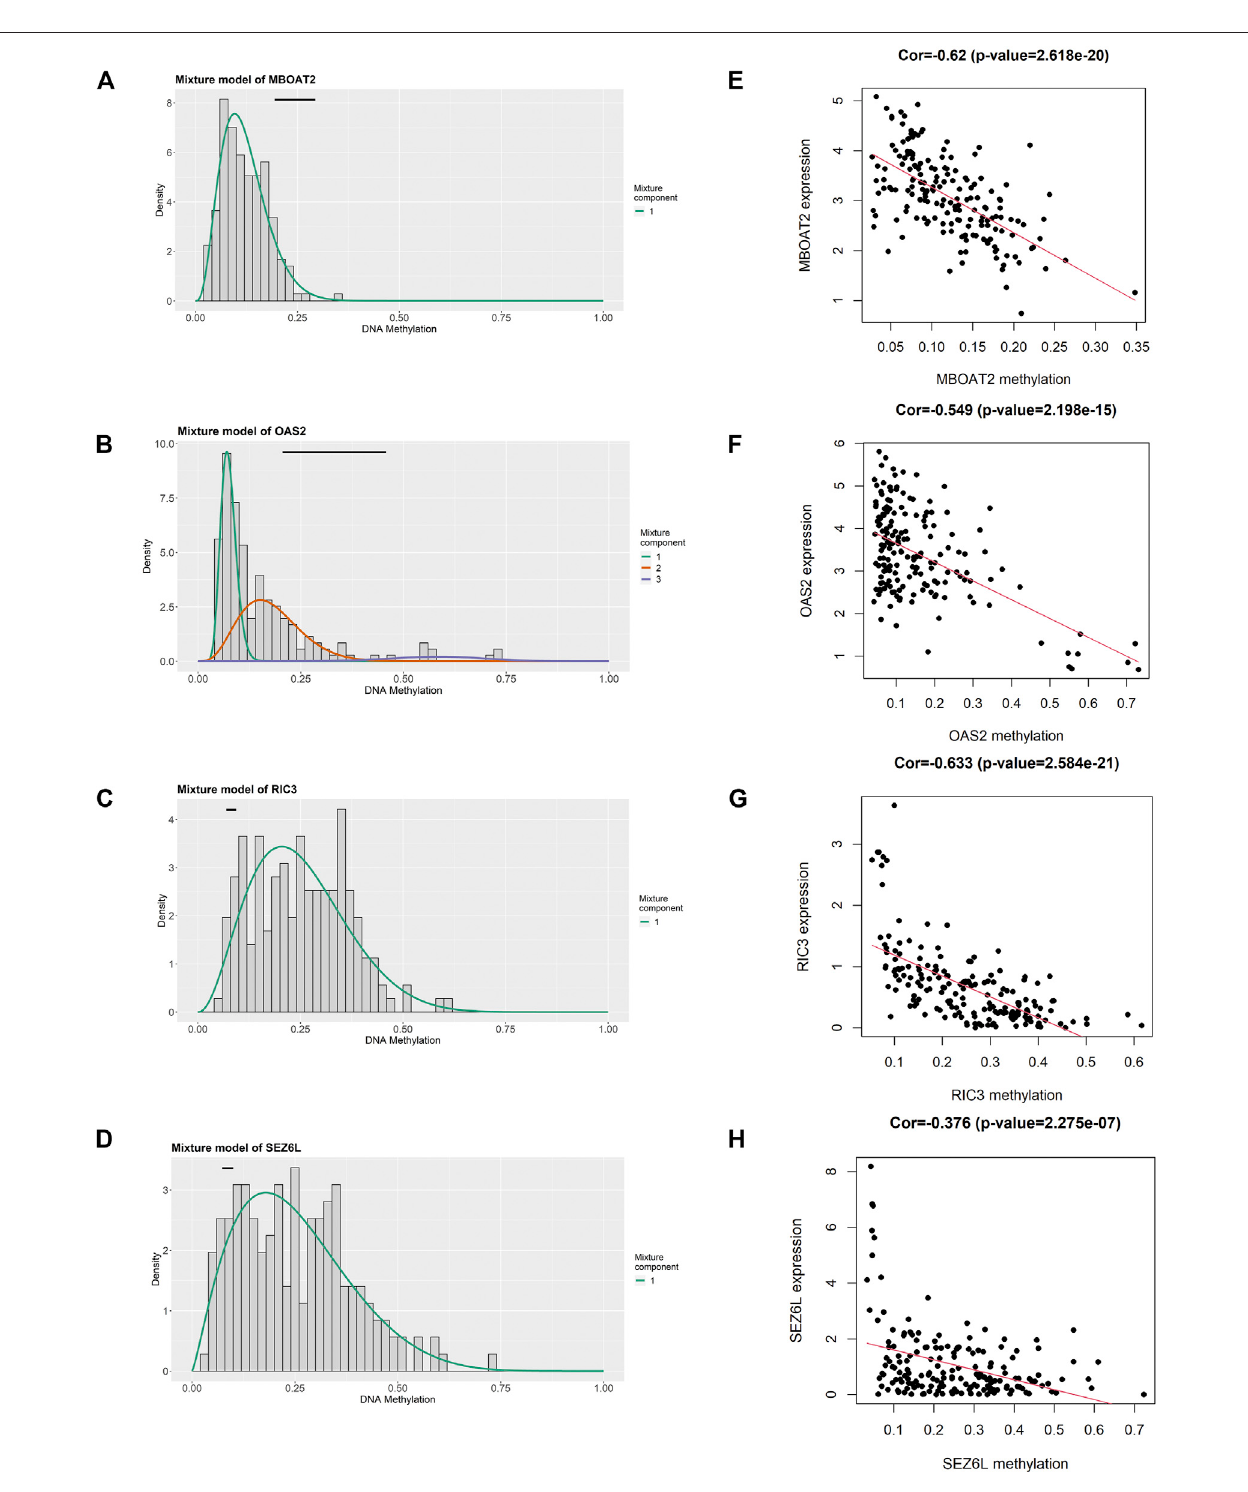
FIGURE 5 | Identi fi cation of four DNA methylation-driven genes using MethylMix analysis. (A – D) Methylation statuses of four DNA methylation-driven genes. The distributionofMBOAT2,OAS2,RIC3,andSEZ6LmethylationinPCsamplesisdisplayedbythehistogram.Thedistributionofmethylationstatusinthenormalpancreatic samples is displayed by the horizontal black line. (E – H) Regression analysis between the DNA methylation level and mRNA expression level of MBOAT2, OAS2, RIC3, and SEZ6L. PC, pancreatic cancer.